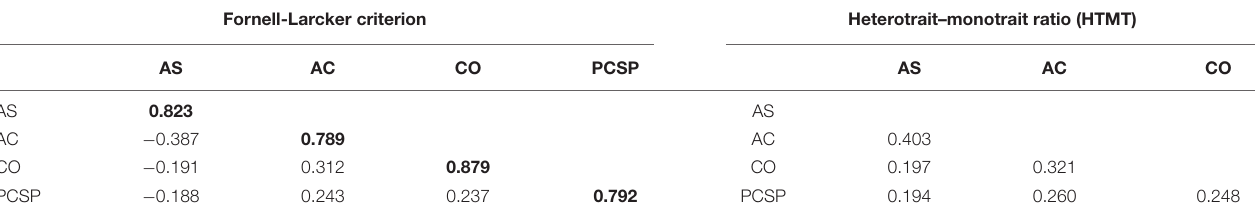
TABLE 4 | Discriminant validity of the measurement model. Fornell-Larcker criterion